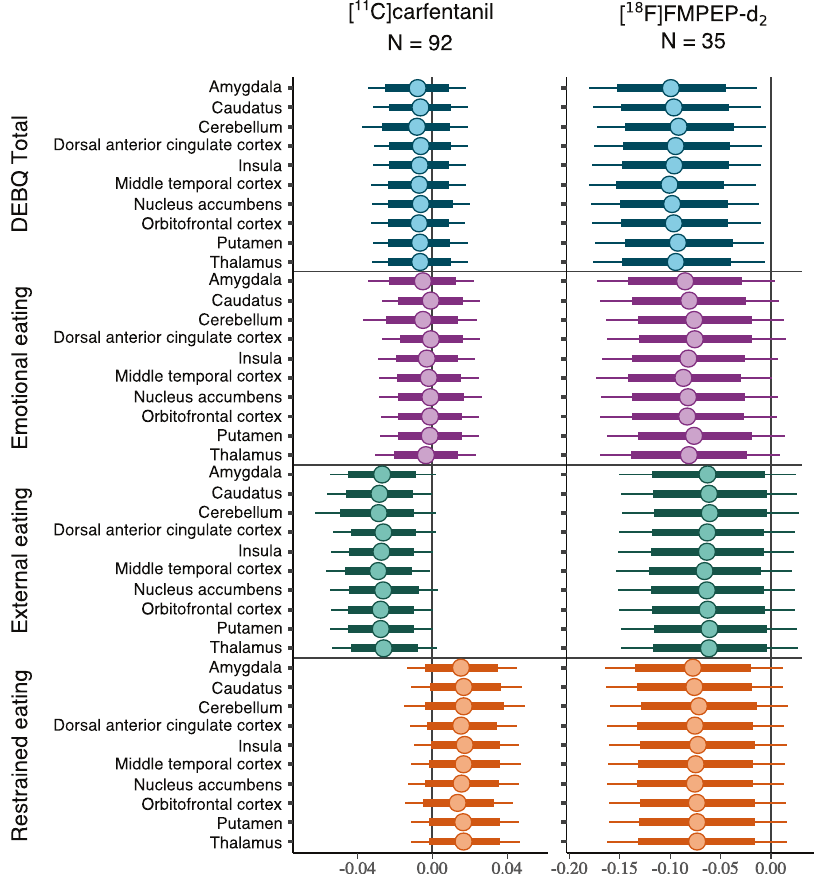
Fig. 2 Regional associations of Total DEBQ and subscale scores with μ -opioid and CB 1 receptor availabilities. The fi gure shows posterior distributions of the regression coef fi cients for Total DEBQ and subscale scores on log-transformed [ 11 C]carfentanil binding potential ( BP ND ) and [ 18 F]FMPEP- d 2 volume of distribution ( V T ) in ten regions of interest. Age (and PET scanner for [ 11 C]carfentanil data) are controlled as covariates. The colored circles represent posterior means, the thick horizontal bars 80% posterior intervals, and the thin horizontal bars 95% posterior